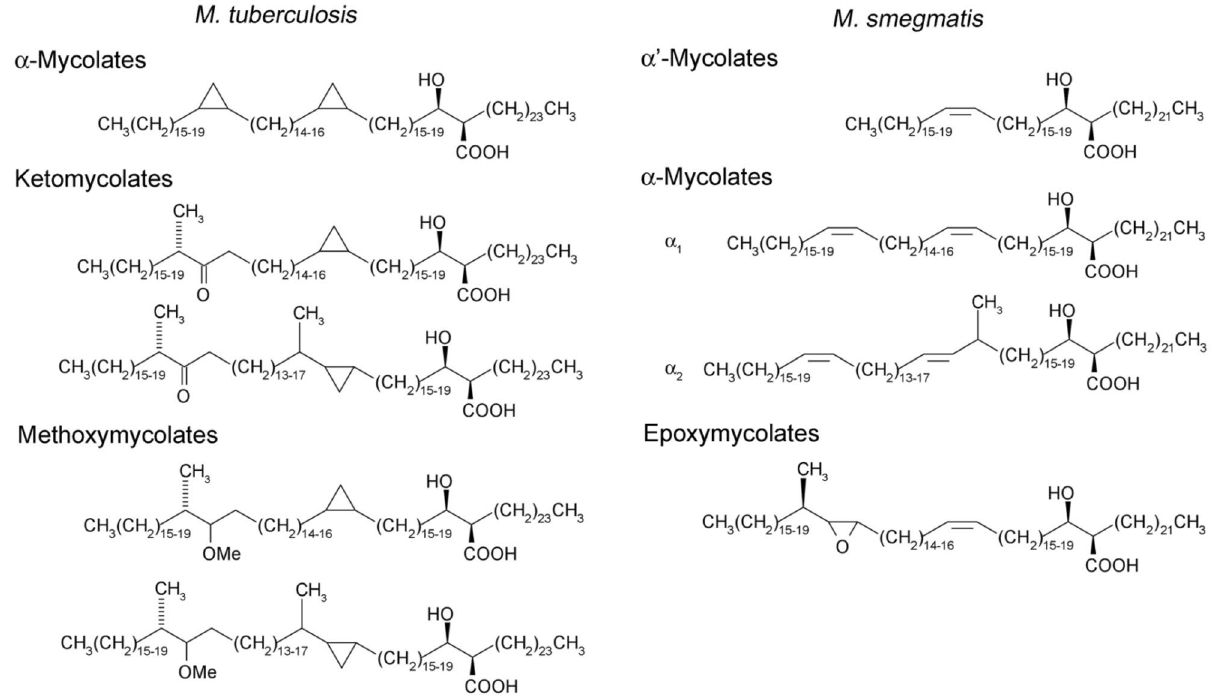
Figure 1. Structures of subclasses of mycolic acids found in M. tuberculosis and M. smegmatis